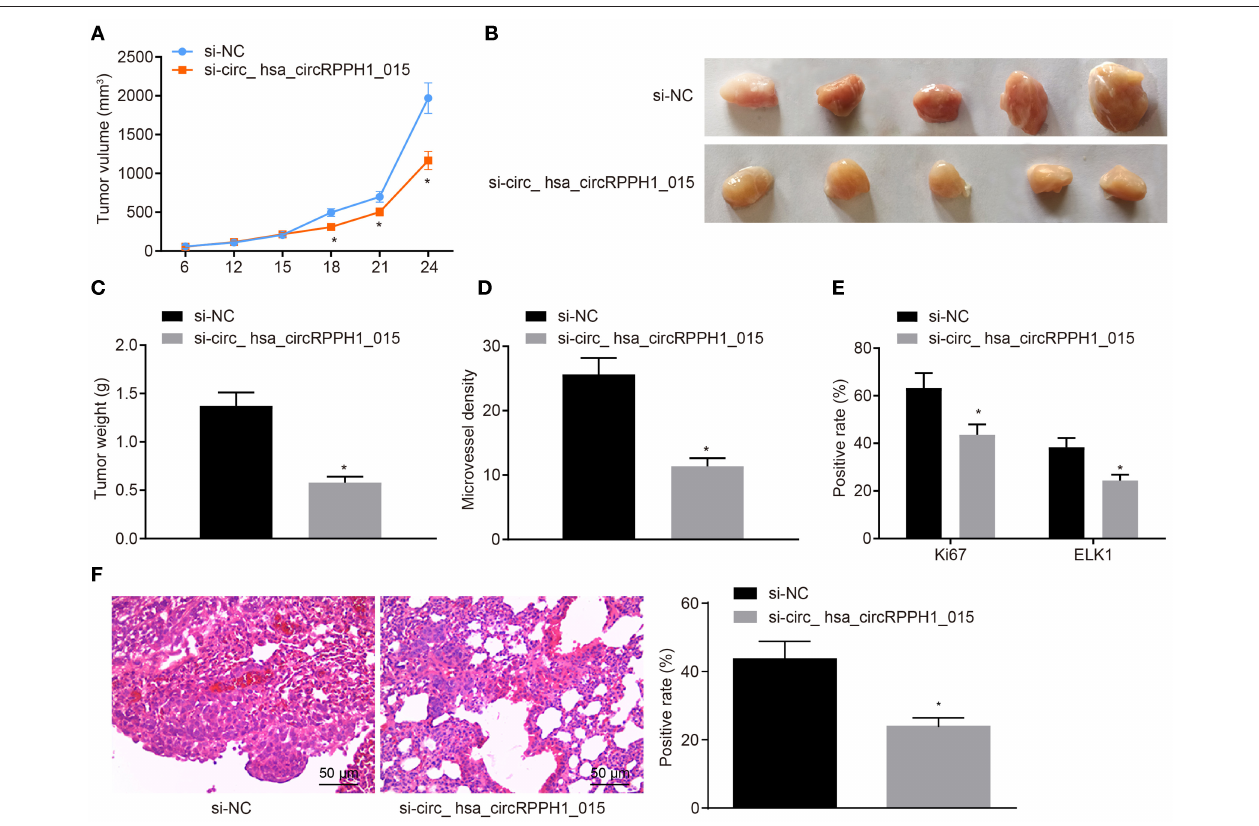
FIGURE 7 | Silencing of hsa_circRPPH1_015 inhibits xenograft tumorigenesis in nude mice. (A) Tumor volume in nude mice. (B) Representative image of xenograft tumor formation in nude mice. (C) Tumor weights in nude mice. (D) MVD of nude mice in each group identified by immunohistochemistry. (E) The positive rates of Ki67 and ELK1 in tumors of nude mice tested by Immunohistochemistry. (F) The number of lung metastases of tumor cells after interferencing hsa_circRPPH1_015 expression by HE staining. * p < 0.05 vs. the si-NC group (nude mice bearing MCF-7 cells transfected with si-NC), n = 10. The quantitative analysis results were measurement data and compared by unpaired t -test between two groups and by one-way ANOVA among multiple groups. Values were obtained from three independent experiments. MVD, micro-vessel density; ELK1, ETS-domain containing protein; HE, Hematoxylin-eosin; si-NC, small interfering RNA-negative control; ANOVA, analysis of